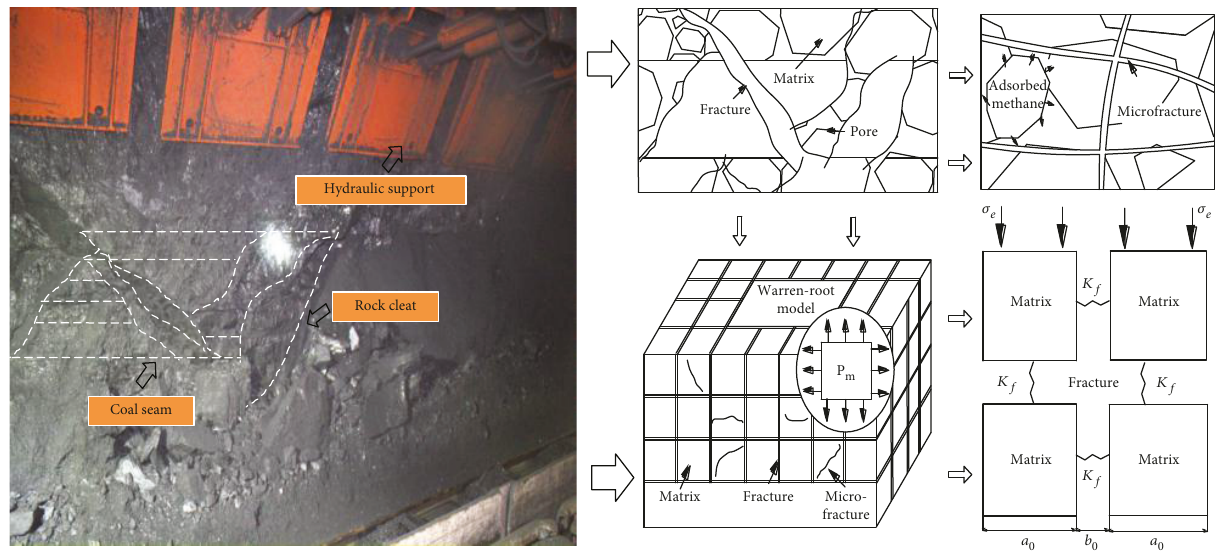
Figure 2: The process of methane migration in coal